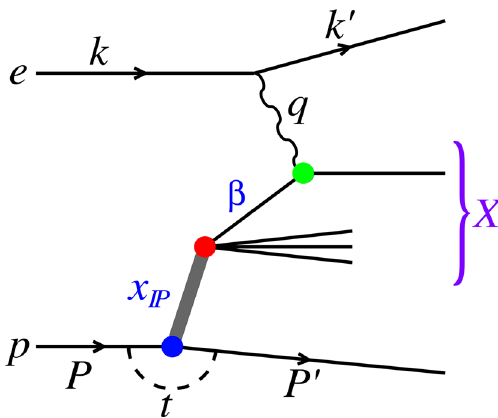
Fig. 1 RepresentativeFeynmandiagramfortheneutralcurrentdiffrac- tive DIS process ep →